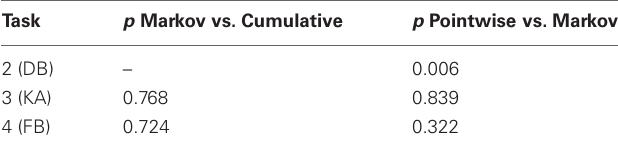
Table 1 | Model sets